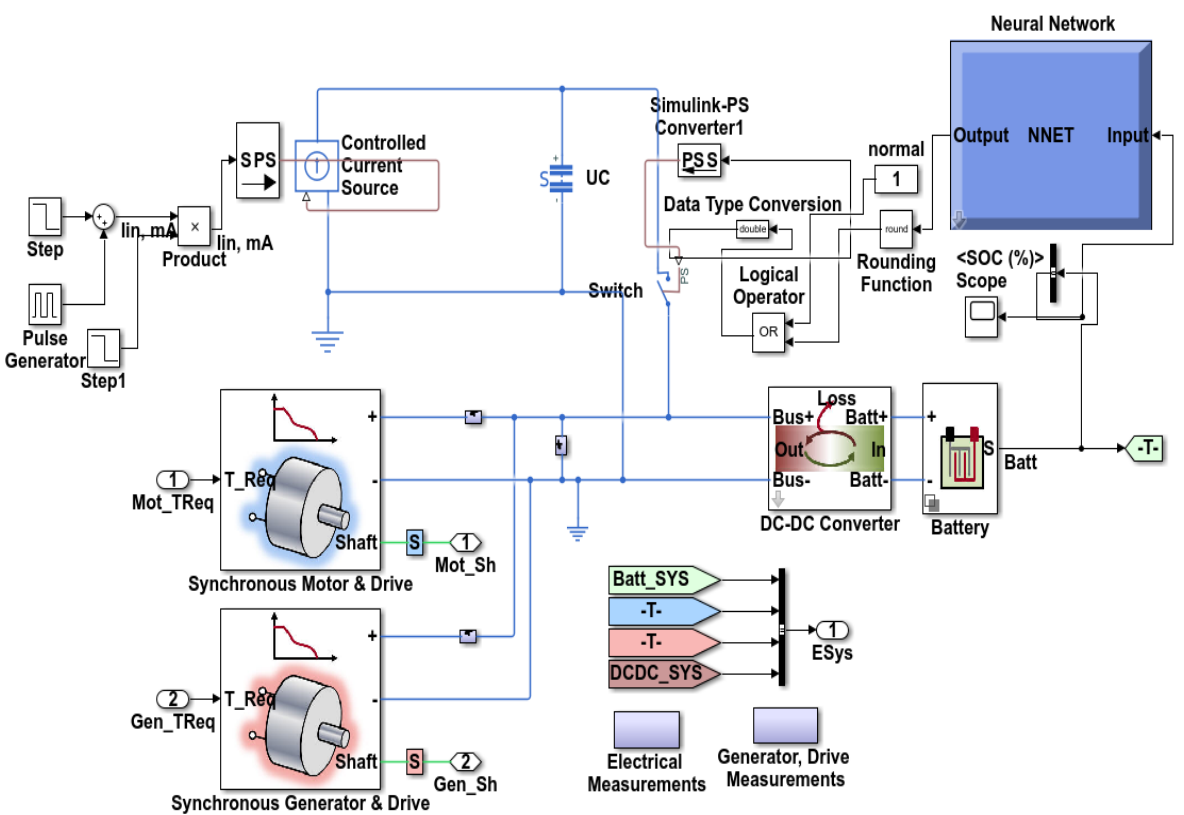
Figure 7. Simulation design of the proposed ANN–AOA method.